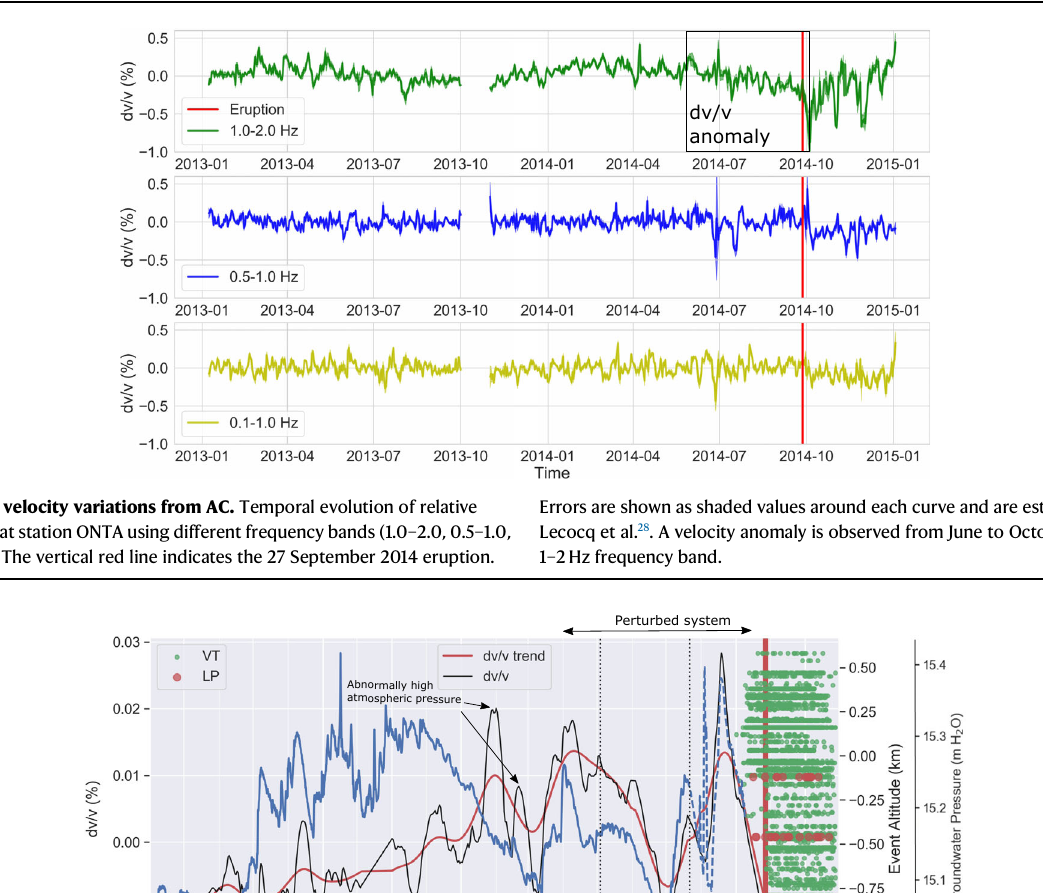
stations(GOT,bluesquare,Fig.1).ThespikesinJulyandAugust2014correspondto a period attributed to sensor problems 41 . The red vertical solid line indicates the 27 September 2014 eruption, whereas black vertical dashed lines correspond to local earthquakes detected by our study. Long Period (LP) and Volcano Tectonic (VT) catalogsshownasredandgreendotsfromAugustonwardsandarefromZhangand Wen 44 . Rain and snow data were recorded at the station located nearby ONTN between 2012 – 2014 (Fig. 1) to remove the seasonal component.